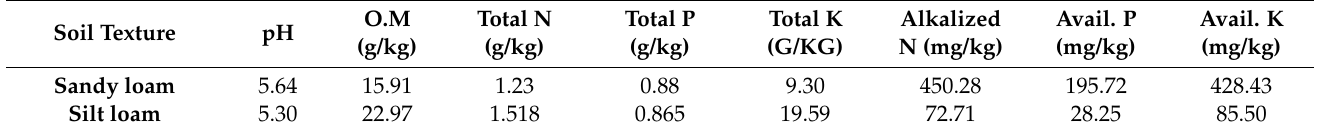
Table 2. Results of the soil chemical